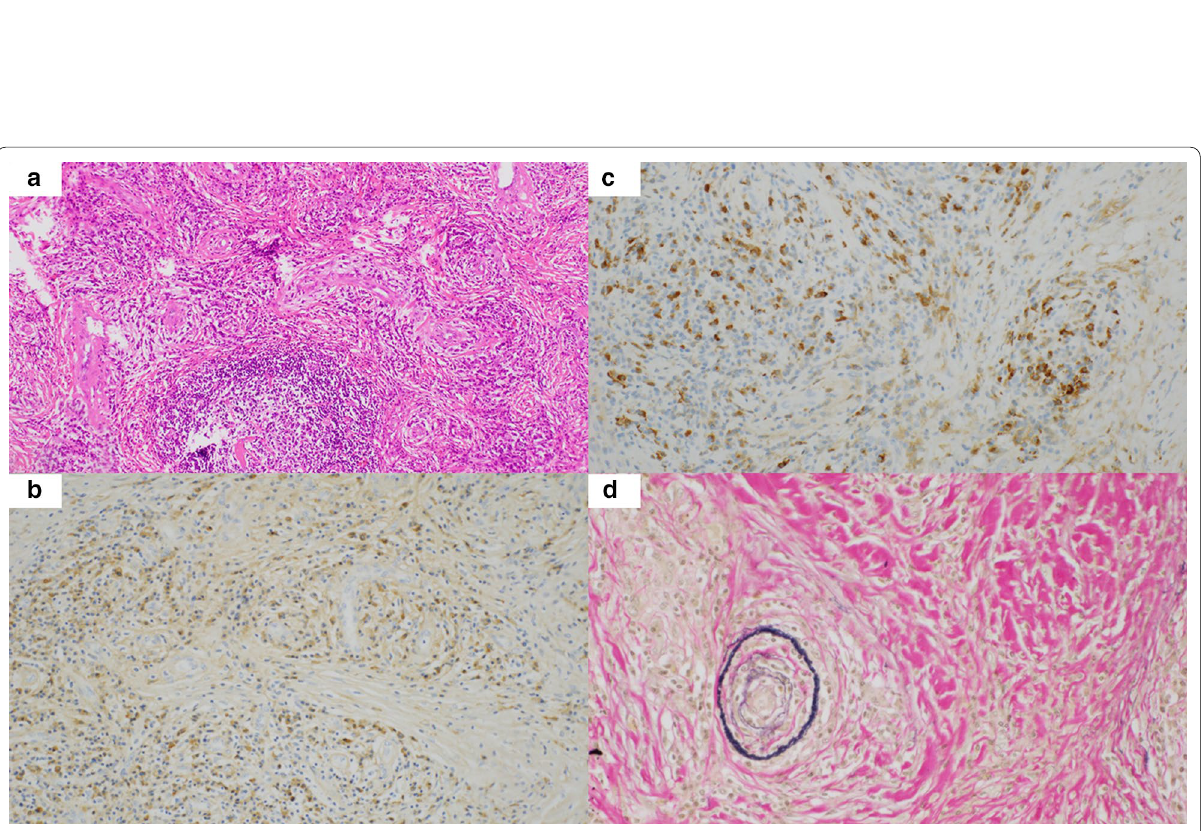
Fig. 3 Pathological findings of the mediastinal mass. a Hematoxylin and eosin stain showed a fibrosis with plasma cell infiltration ( Immunohistochemical stain of IgG showed that IgG plasma cell infiltration was confirmed ( that IgG4-positive plasma cells were ascertained and the IgG4/IgG cell ratio was obliterative phlebitis was detected (